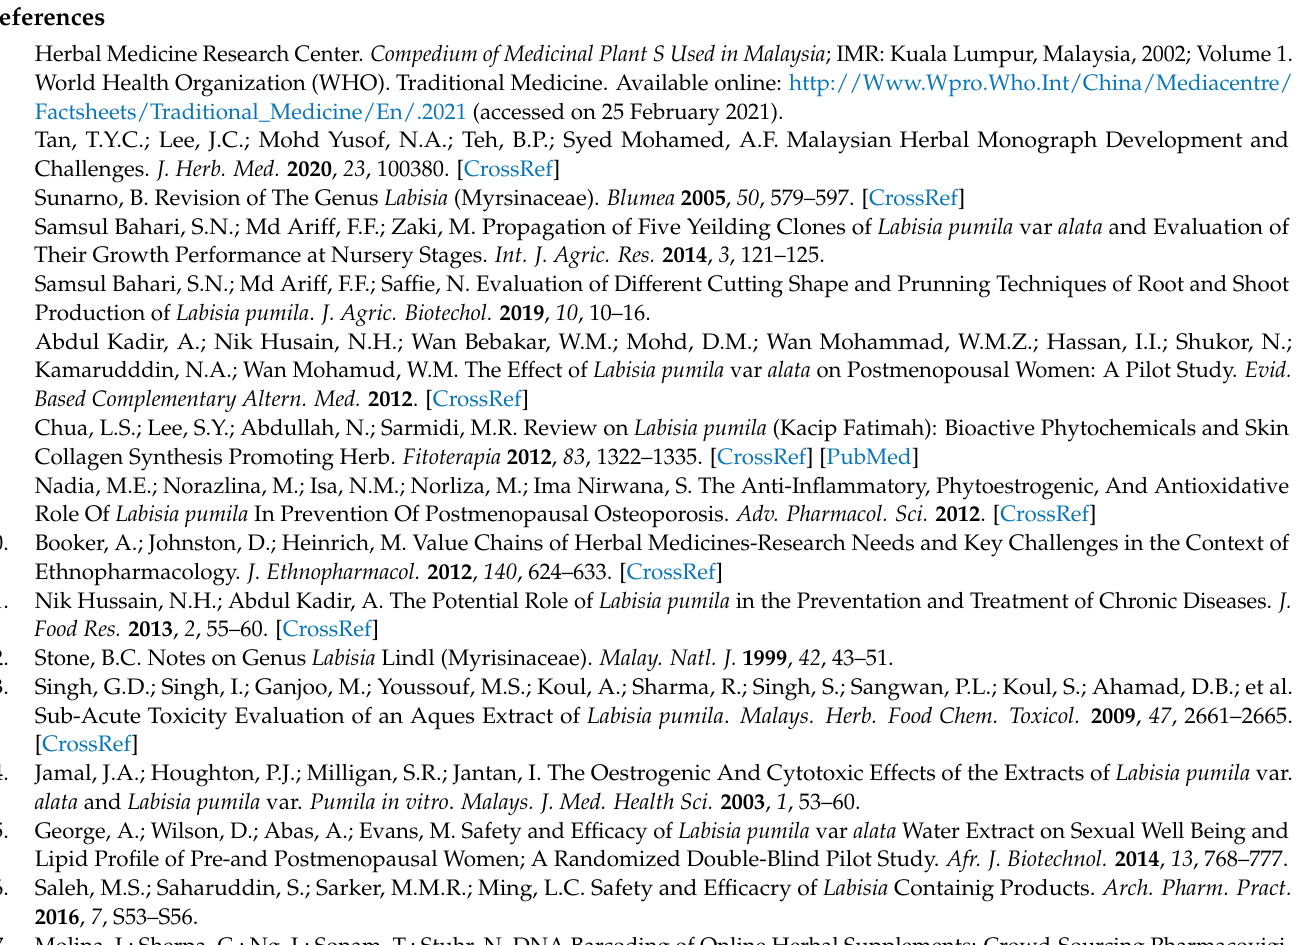
Table S2. The observable contents of L. pumila HMPs; Figure S1. Calibration curve of gallic acid; Figure S2. Calibration curve of